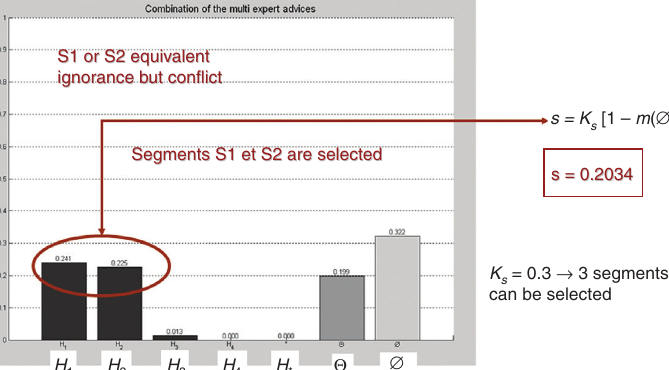
Figure 4. Masses Combination of Criteria c The columns are ∅ values computed from Eqs. (4)–(7),